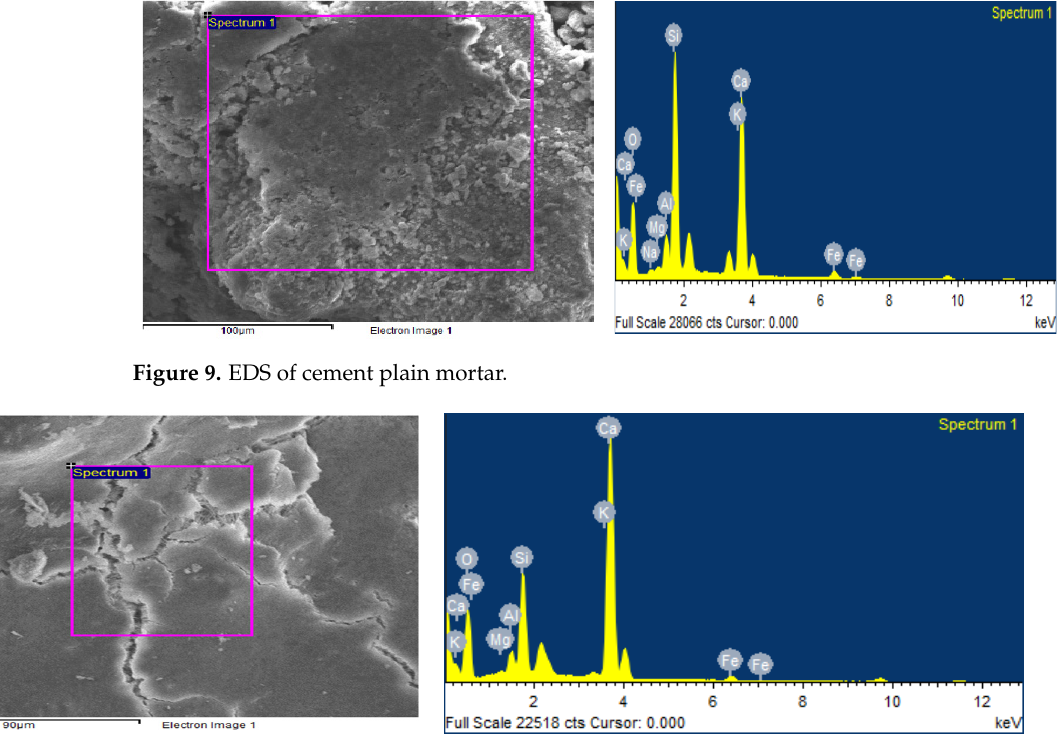
Figure 10. EDS of cem+bio mortar. Table 3. EDS analysis of cement-based mortars with and without biostabiliser.